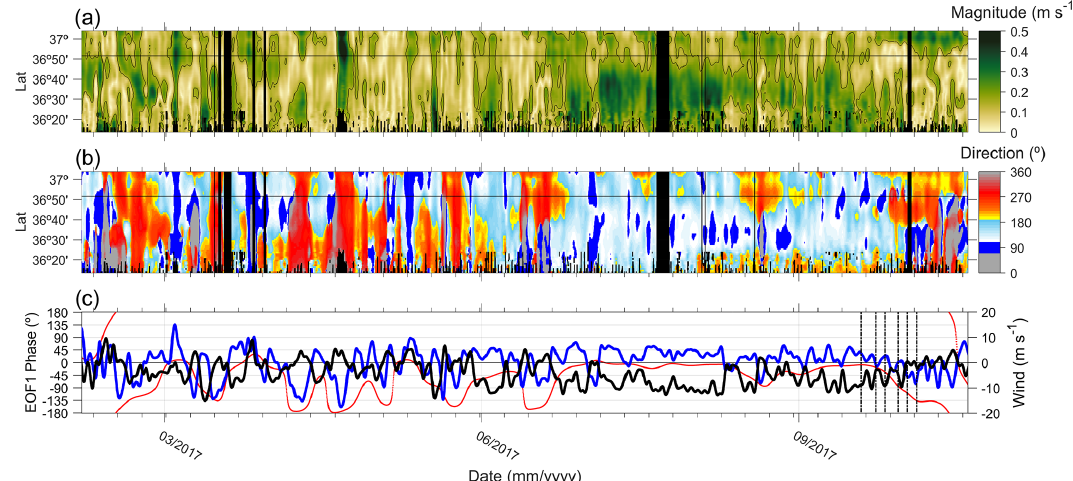
Figure 10. Hovmöller diagram of (a) magnitude and (b) directions of currents at transect TrW; (c) zonal (blue line) and meridional (black line) of sub-inertial ERA5 wind (https://cds.climate.copernicus.eu, last access: 18 September 2021) extracted at 36 ◦ 45 (cid:48) N, 8 ◦ 30 (cid:48) W along with the phase of EOF mode 1 (red points). Dashed vertical lines indicate the day of each of the SST maps represented in Fig. 11. Major ticks on x axes represent the first day of the indicated month, and minor ticks represent 1-week intervals.